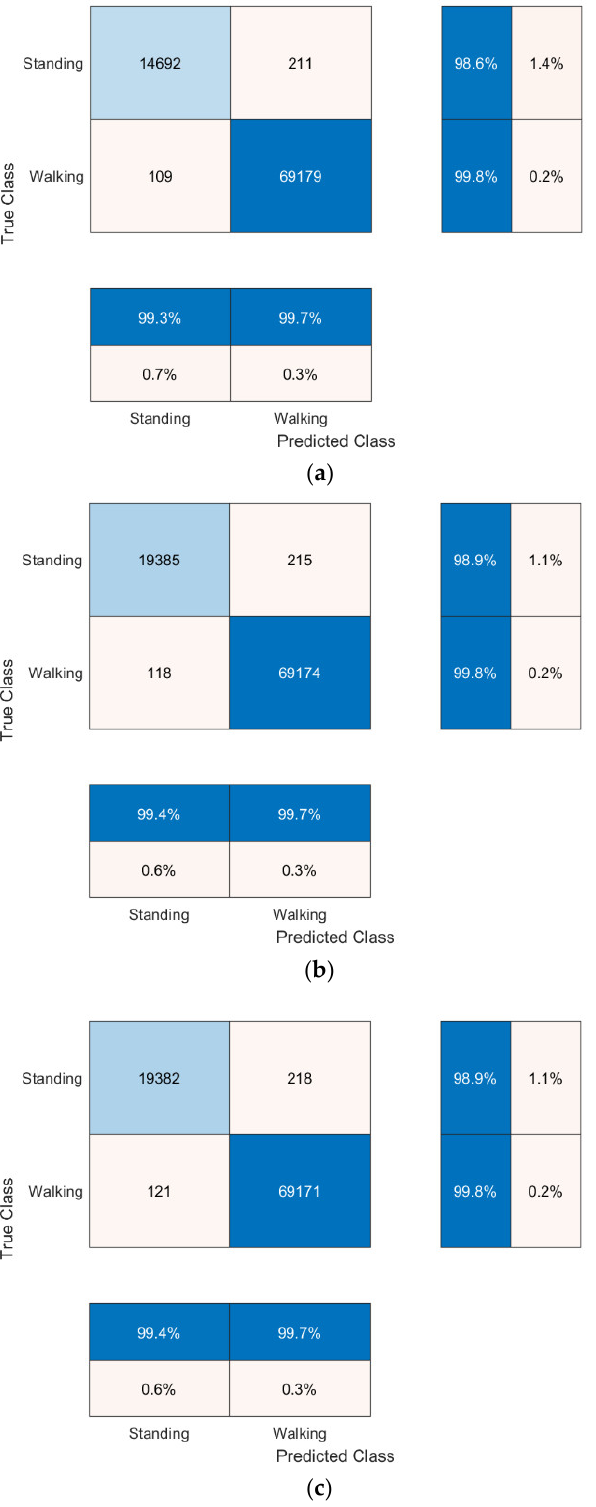
Figure 1. Confusion matrices for ( a ) Binary Classifier, Feature Set A, Model.1 (k-NN Manhattan